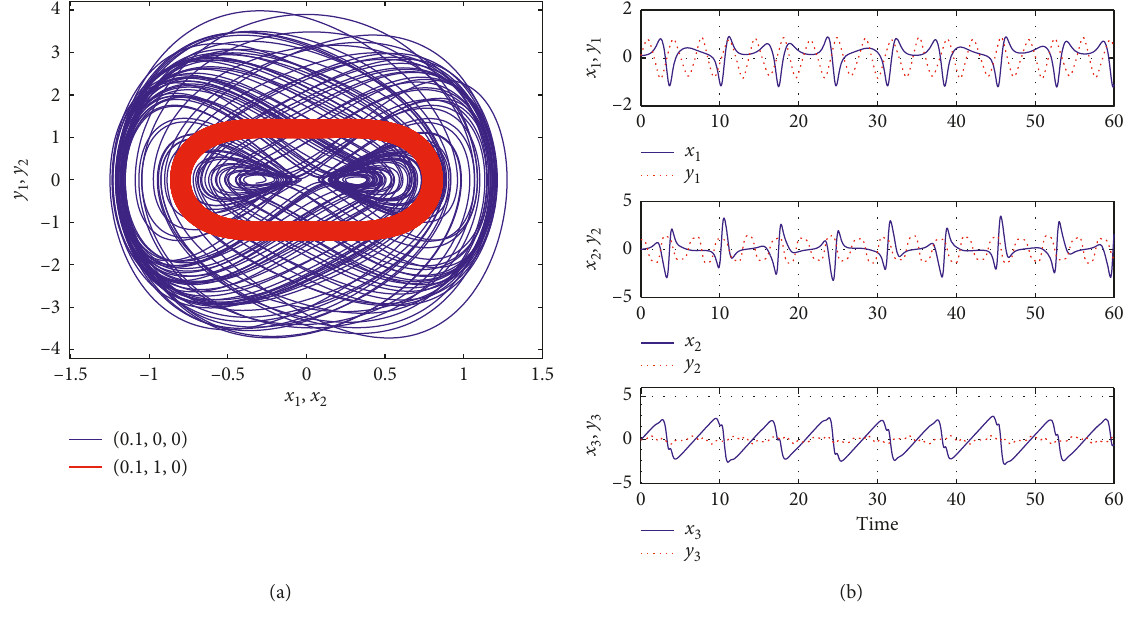
Figure 12: (a) Phase diagram and (b) state trajectories with x ( 0 ) � ( 0 . 1 , 0 , 0 ) and y ( 0 ) � ( 0 . 1 , 1 , 0 ) .